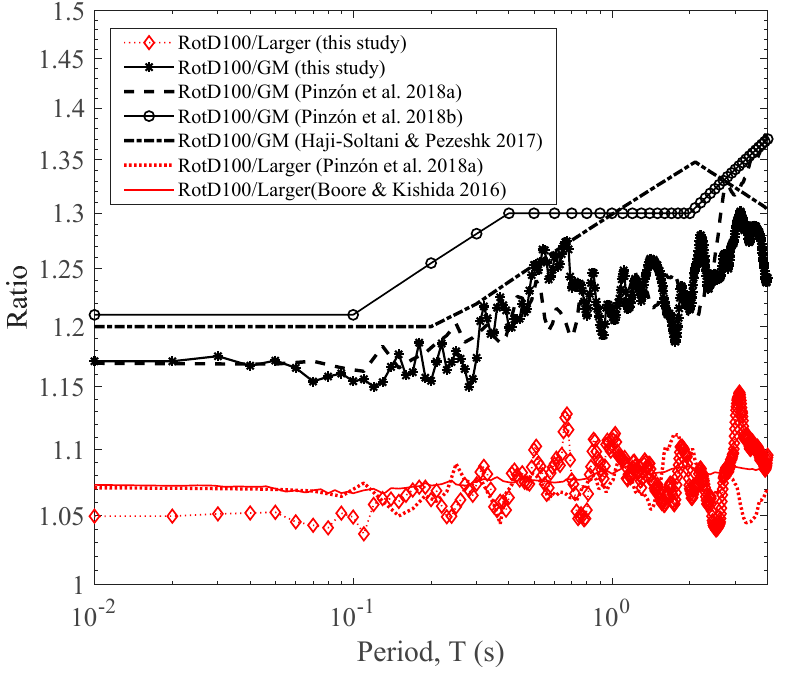
Figure 5. Comparison of the ratios RotD100 / GM and RotD100 / Larger obtained with the 2016 Ecuador earthquake motion with the ratios obtained by other researchers.